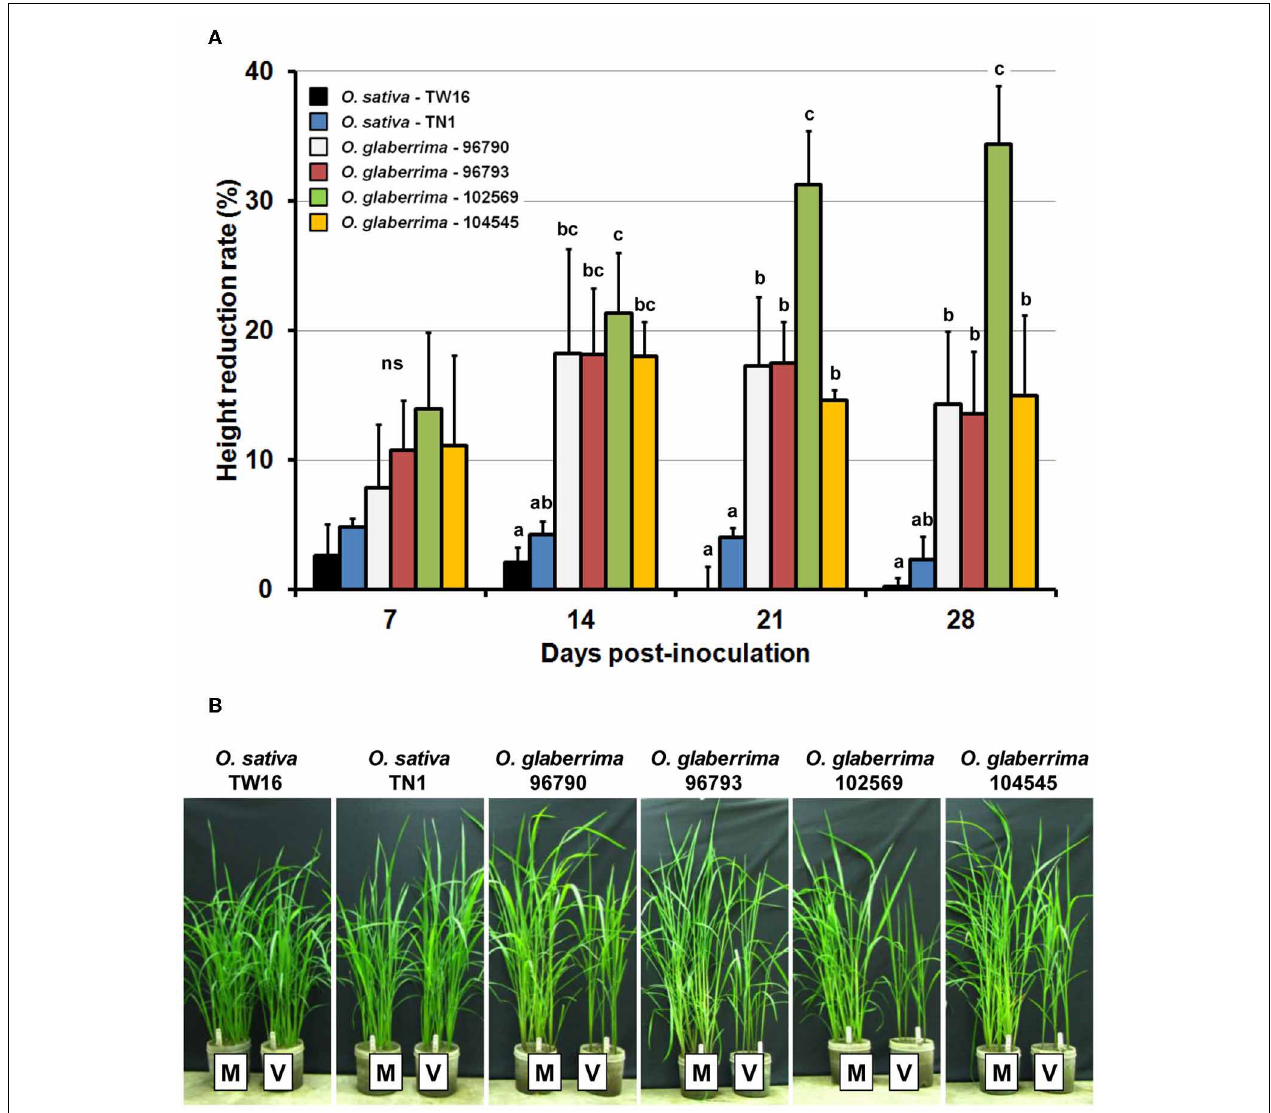
FIGURE 1 | Height reduction in Oryza glaberrima and O. sativa infected with Rice tungro spherical virus (RTSV). (A) Temporal changes in height reduction rates. Vertical bars and vertical lines indicate mean and standard error of mean, respectively, for the height reduction rate at the respective time points. Means and standard error of mean were based on three independent experiments ( n = 5